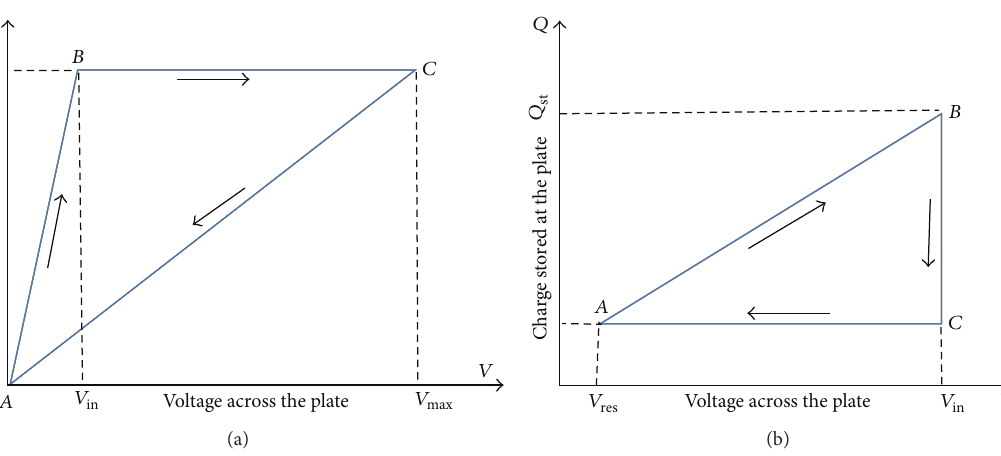
Figure 5: Operation of ES-VEH in constant voltage mode.